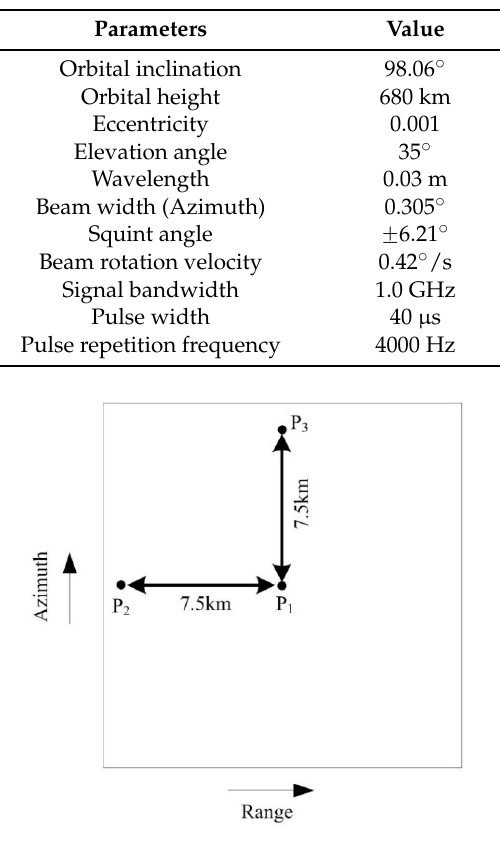
Figure 11. The simulated swath: P 1 is at the swath center. P 2 and P 3 are at the range edge and the azimuth edge, respectively, which are all 7.5 km away from P 1 .